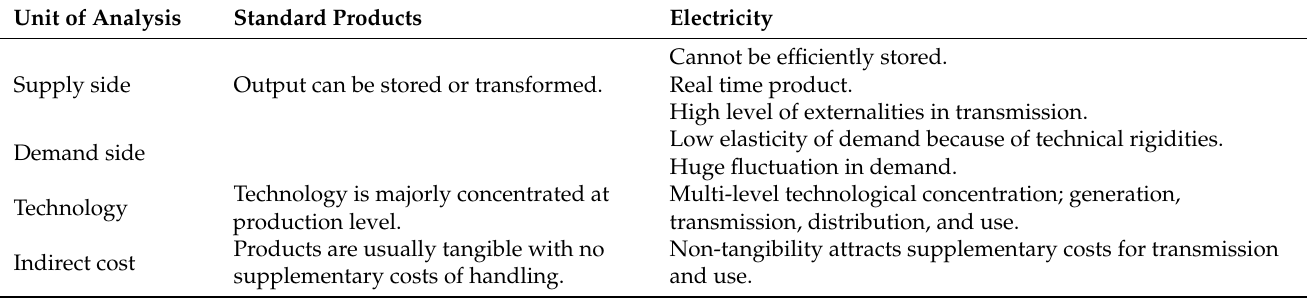
Table 3. Differentiating electricity as a good from other general